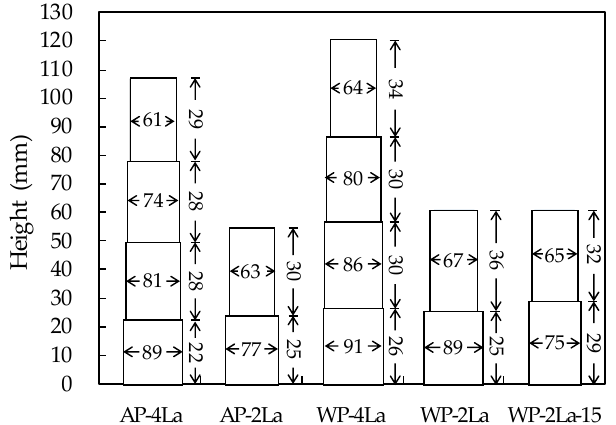
Figure 11. Measurement of height and width for each printed layer of parts.